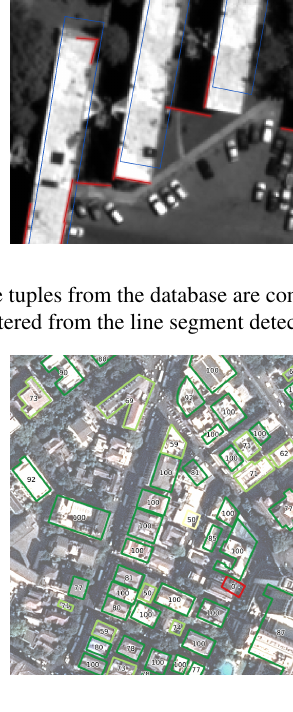
Figure 7. Metrics computation after registration of the vector dataset